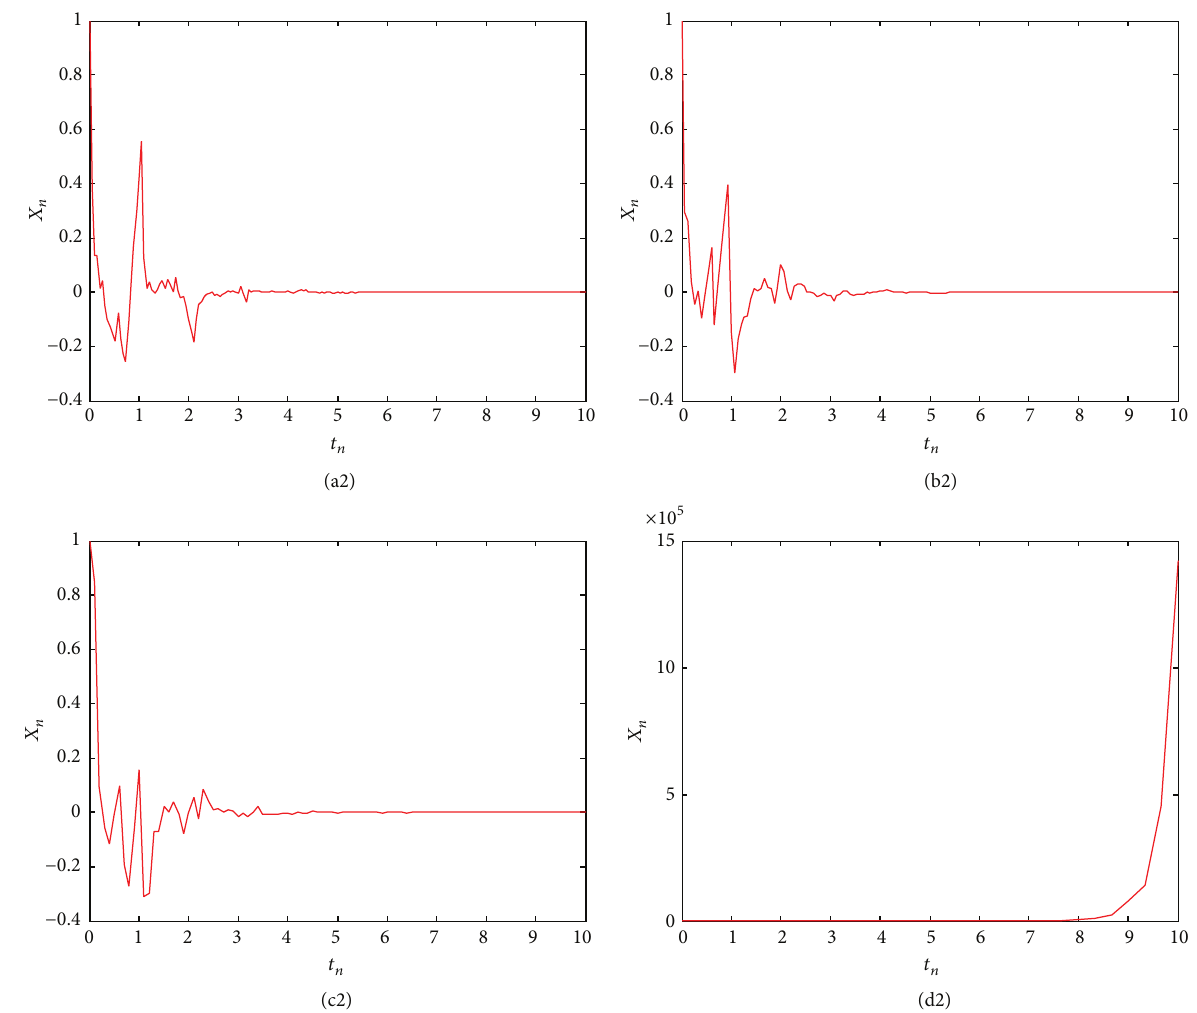
Figure 2: Simulations with the Heun method for (7) with 𝑎 = −9, 𝑏 = −1, 𝑐 = 1.1 , and 𝑑 = 0.9 . ( a 2) ℎ = 1/19 , ( b 2) ℎ = 1/15 , ( c 2) ℎ = 1/11 , and ( d 2) ℎ = 1/3